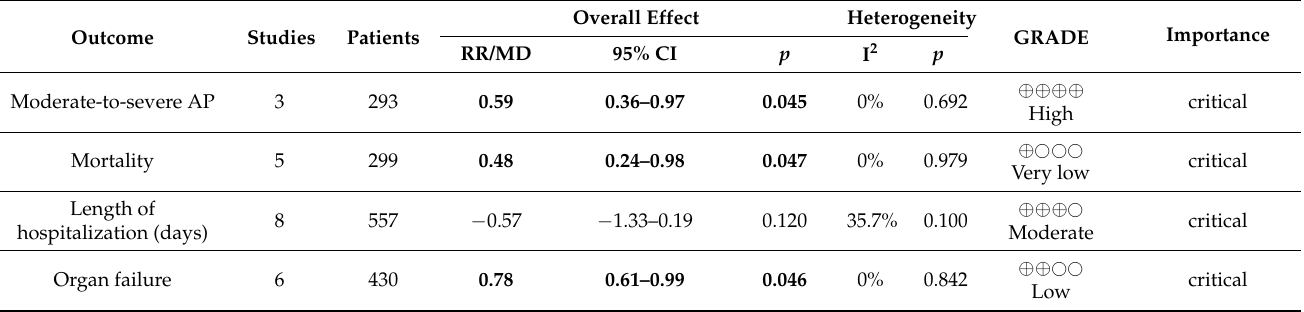
Table 2. Effect sizes, heterogeneity and quality of evidence for outcomes included in the meta- analyses. Abbreviations: AP: acute pancreatitis. Significant results are highlighted in